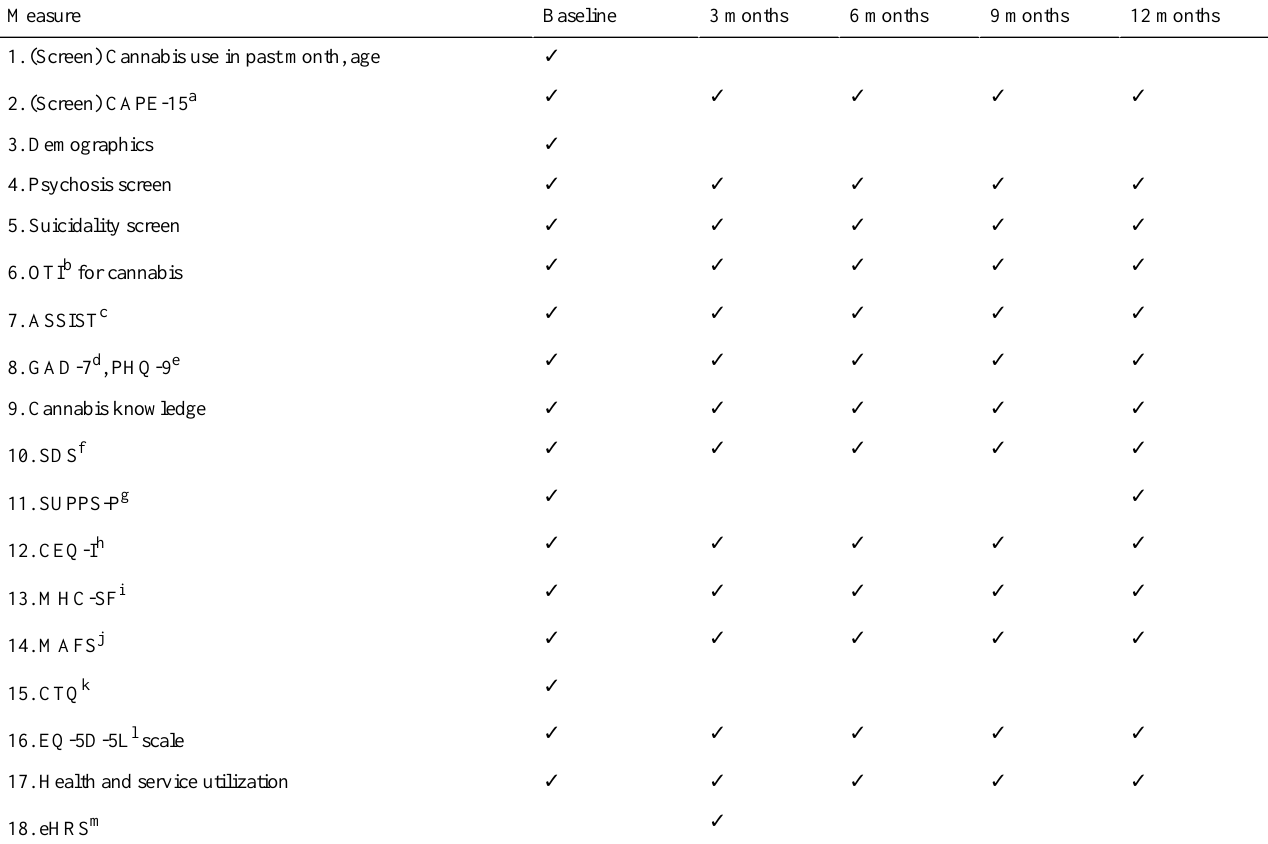
Table 1. Assessment